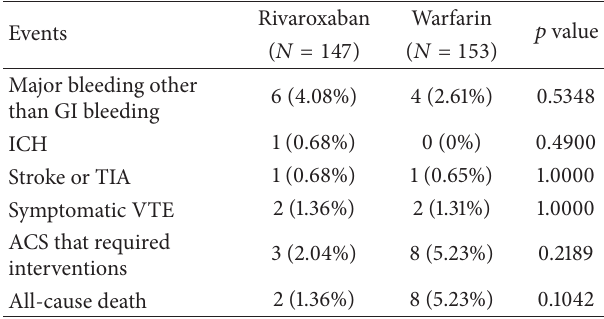
Table 5: Secondary